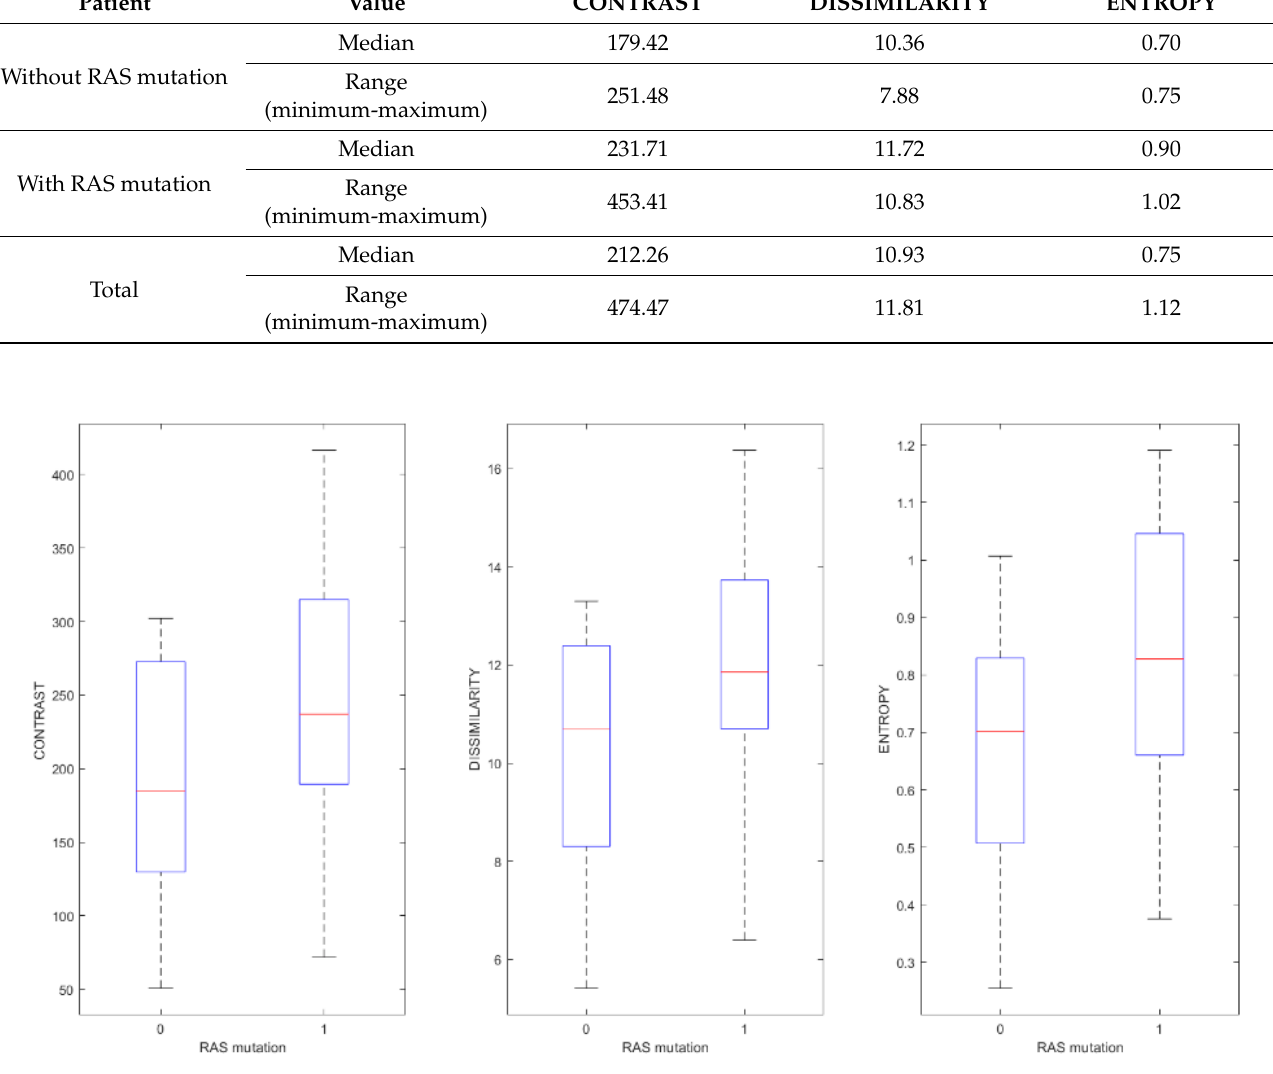
Table 4. Median and range values for the radiomic extracted metrics.